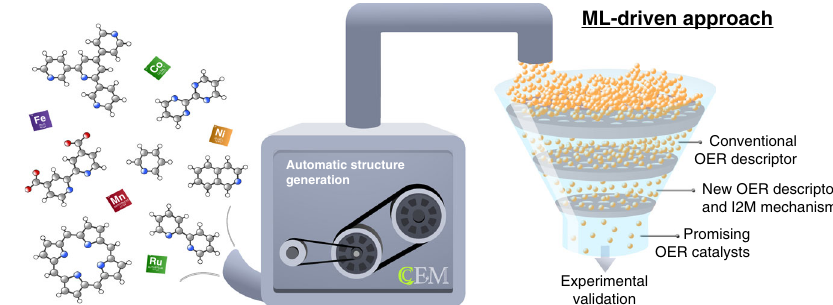
Fig. 7 Proposed approach for the accelerated discovery of ideal